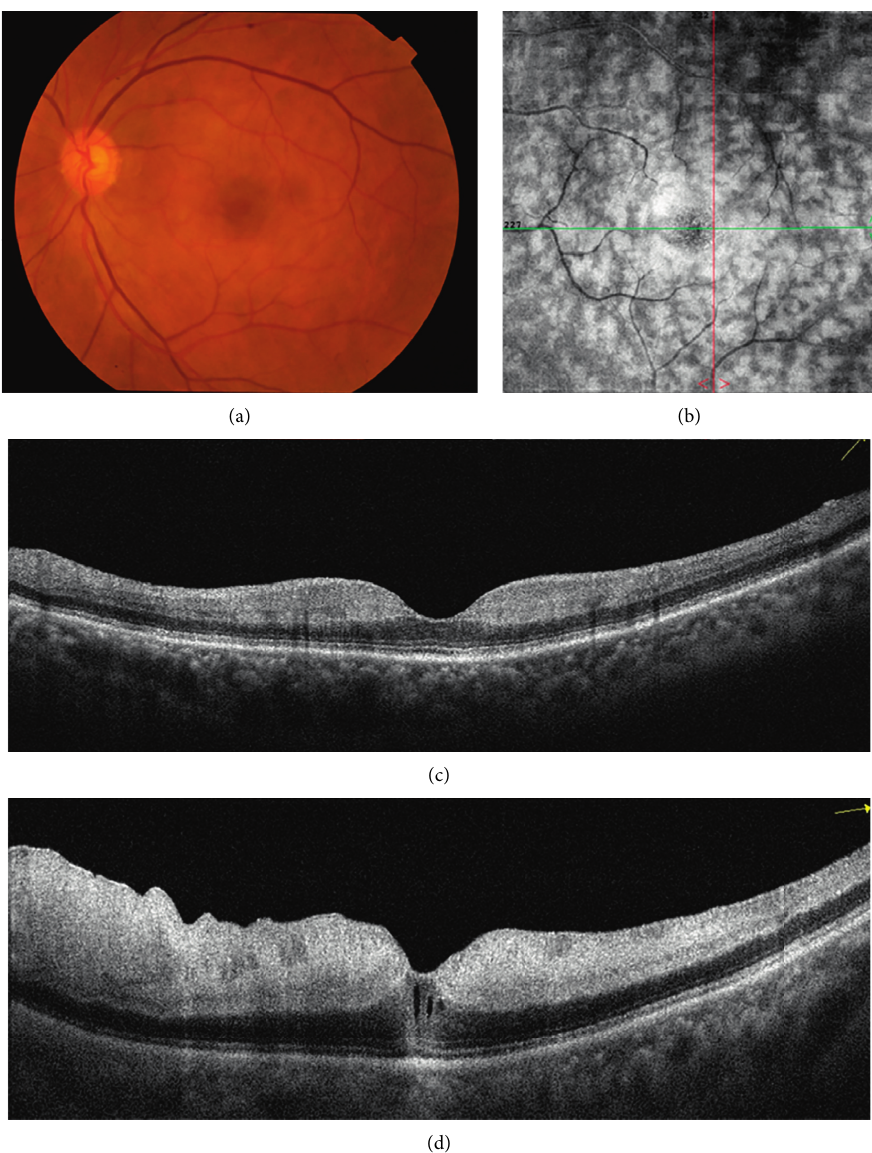
Figure 2: Multimodal imaging from a 55-year-old hypertensive man with partial CRAO and fern-like pattern PAMM at baseline and complete CRAO with diffuse middle and inner retinal ischemia. (a) Fundus photography illustrated perifoveal retinal whitening in the central macular region. (b) En face OCT illustrated a perivenular fern-like pattern with periarterial sparing. (c) PAMM lesions (hyper- reflective bands at the level of INL) in a skip pattern revealed on the cross-sectional OCT B-scan. (d) One week later, the patient’s vision declined to 2/200, and SD-OCT illustrated diffuse middle and inner retinal